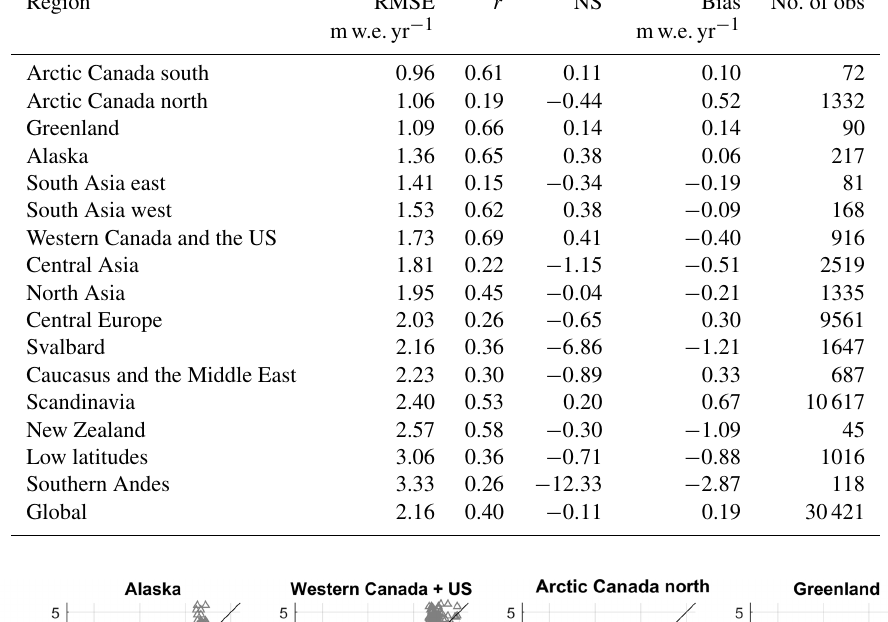
Table 3. Root-mean-square error (RMSE), correlation coefficient ( r ), Nash–Sutcliffe efficiency coefficient (NS), mean bias (Bias), and the number of elevation-band mass balance observations (No. of obs) for RGI6 regions. The regions are ranked from the lowest to the highest RMSE.